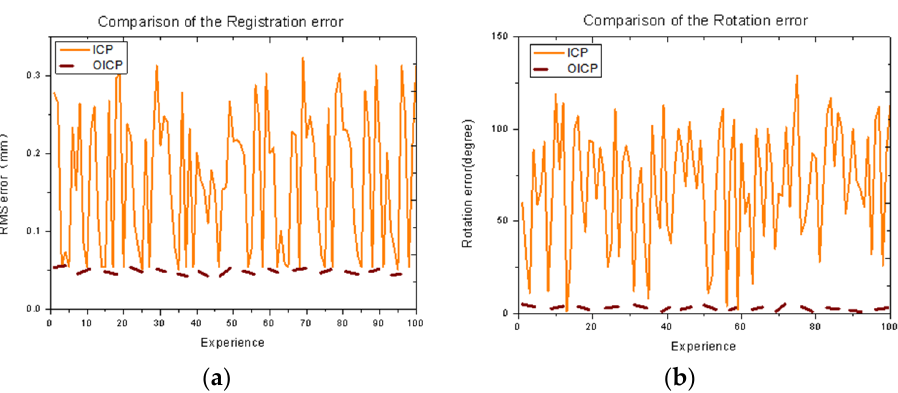
Figure 11. Comparison of the ( a ) registration error and ( b ) rotation error on random points by OICP method versus ICP initialized with identity rotation and zero translation. Ground truth rotation and translation lie randomly within ±100 degrees and ±0.5, respectively (point cloud overlap = 70%).